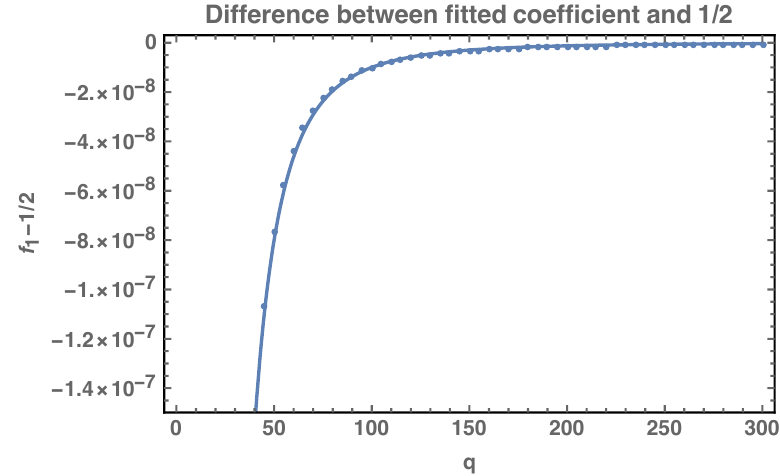
Figure 5. This plot shows the di(cid:11)erence between the (cid:12)tted 1 =q coe(cid:14)cient for (cid:1) I , called f 1 (eq. (4.9)), and 1 as a function of the starting point of (cid:12)tting. The endpoint of all the (cid:12)ts is (cid:12)xed 2 at q = 415, such that there are enough data points to (cid:12)t for all the di(cid:11)erent starting points of q . It can be seen that the (cid:12)tted coe(cid:14)cient asymptotes to 1 for increasing q ranges. The dots are the 2 (cid:12)tted coe(cid:14)cients, whilst the line approximates them well as 10 (cid:0) 2 q 3